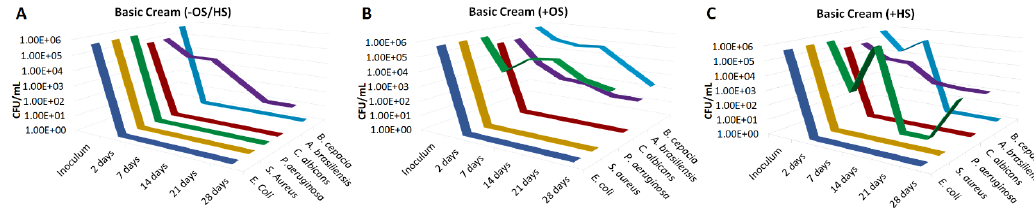
Figure 3. Challenge tests of basic cream formulation supplemented with either octyl salicylate (OS) or homosalate (HS), against five pharmacopeia strains as well as B. cepacia . Basic cream formulation (Table 1), ( A ) without UV-filter ( B ) with 5% OS and ( C ) with 5% HS, were challenged separately with 1 × 10 6 CFU / mL of E. coli , S. aureus , P. aeruginosa , and B. cepacia , and 1 × 10 5 CFU / mL of C. albicans